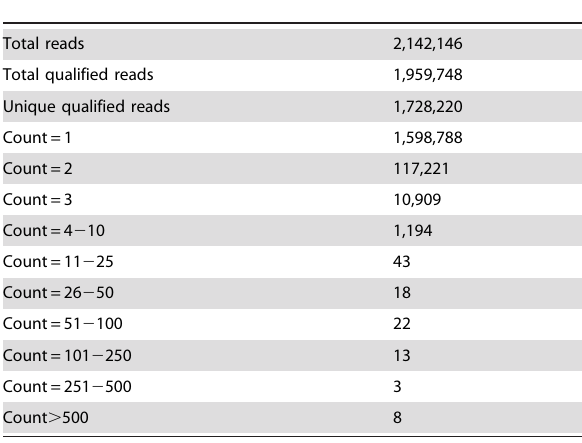
Table 2. Summary of sequencing results for experiment